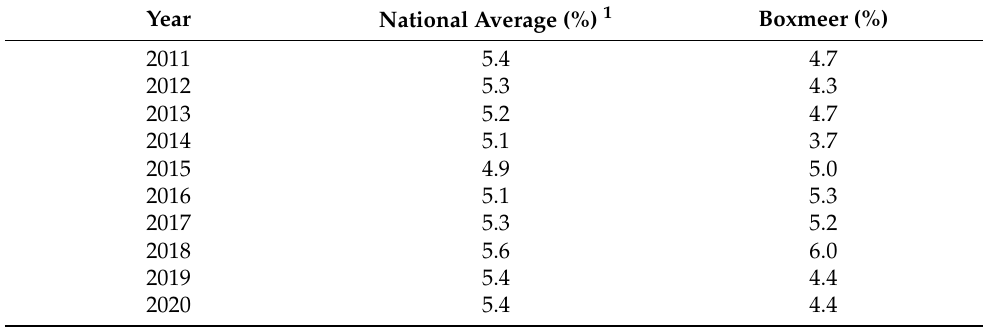
Table 3. Absenteeism as a percentage of total internal staff volume (source: https://www.aeno.nl accessed on 21 June 2021).